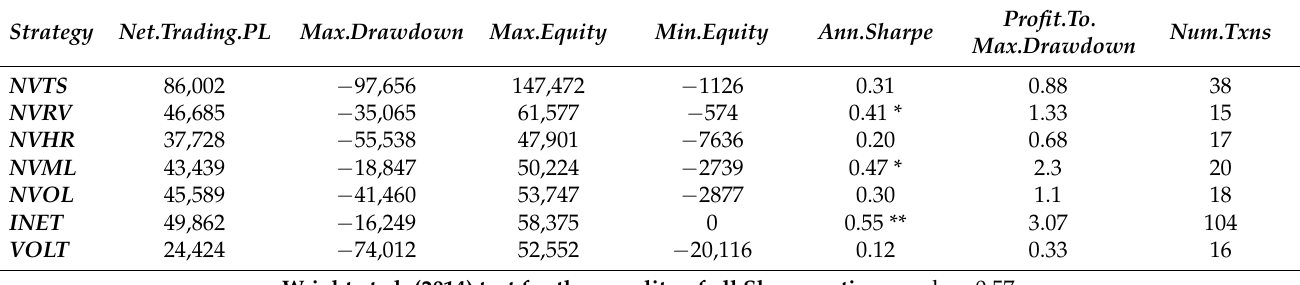
Table 4. Selected evaluation metrics for all trading